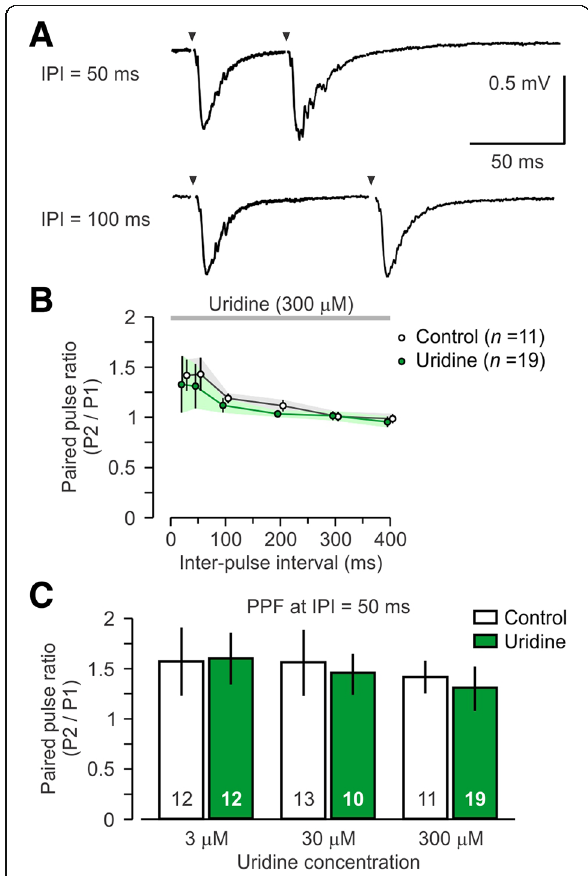
Fig. 2 Null effect of uridine on short-term synaptic plasticity. a Representative traces showing paired pulse stimulation at inter-pulse intervals (IPI) of 50 ms and 100 ms from brain slices treated with high uridine (300 μ M). Stimulation artifacts have been removed and are marked by arrowheads. b Graph showing the paired-pulse ratios (mean ± SEM) across a range of IPIs in brain slices treated with high uridine (300 μ M). Ratios above 1.0 indicate paired-pulse facilitation (PPF), which is similar in the uridine and control groups; P1, slope of fEPSP in response to first pulse; P2, slope of fEPSP in response to second pulse. c Graphs showing the paired-pulse ratios (mean ± SEM) at a single IPI (50 ms) for uridine at three concentrations and control groups. All groups display comparable paired-pulse facilitation. Numbers within bars indicate number of brain slices per